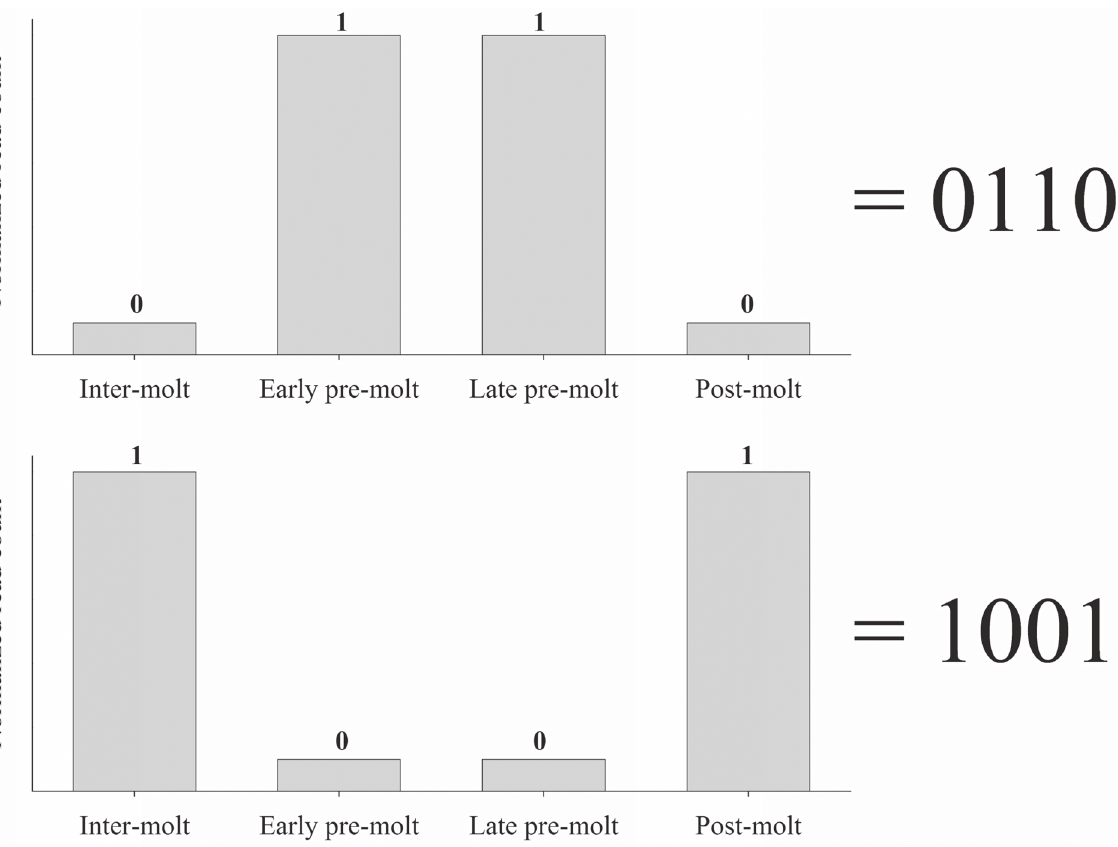
Fig 1. Two representative examples of the binary patterns code used in our study. Top graph — a 0110 pattern in which the quantity of reads in early and late pre-molt is significantly higher, as compared to inter-molt and post-molt ( p -value < 0.05). Bottom graph — a 1001 pattern in which there is a significant increase of reads in inter-molt and post-molt, as compared to early and late pre-molt ( p -value < 0.05). The number 1 in the code represents a high number of reads as compared to a low number of reads, represented with 0. High quantity of reads have a minimum of 10 3 reads.